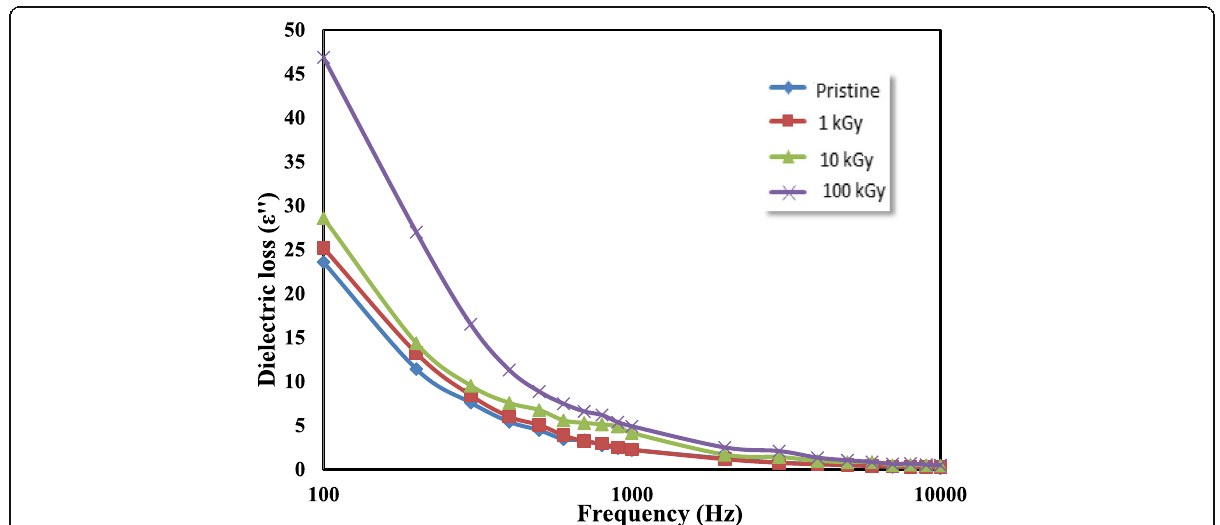
Fig. 3 Frequency dependence of the dielectric loss for the investigated samples at room temperature